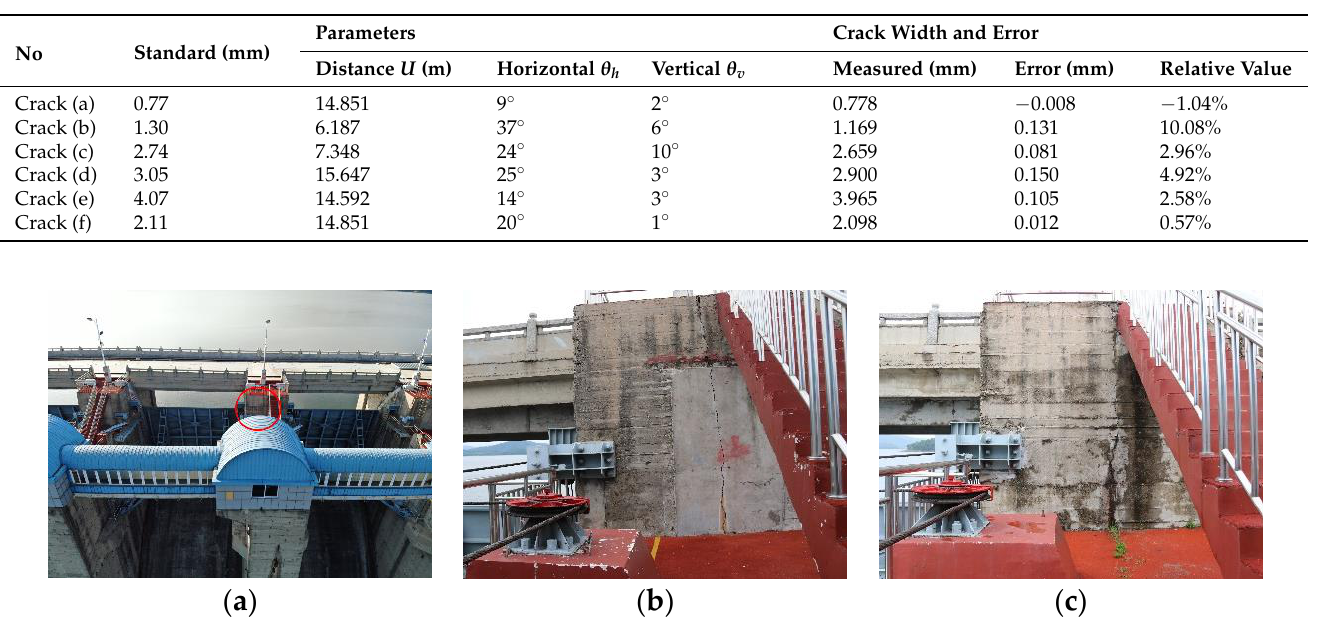
Figure 24. Cracks on the dam pier: ( a ) panorama of the pier, where the red circle is the position of cracks; ( b ) crack with clear concrete background; ( c ) crack with wet and blurred background.